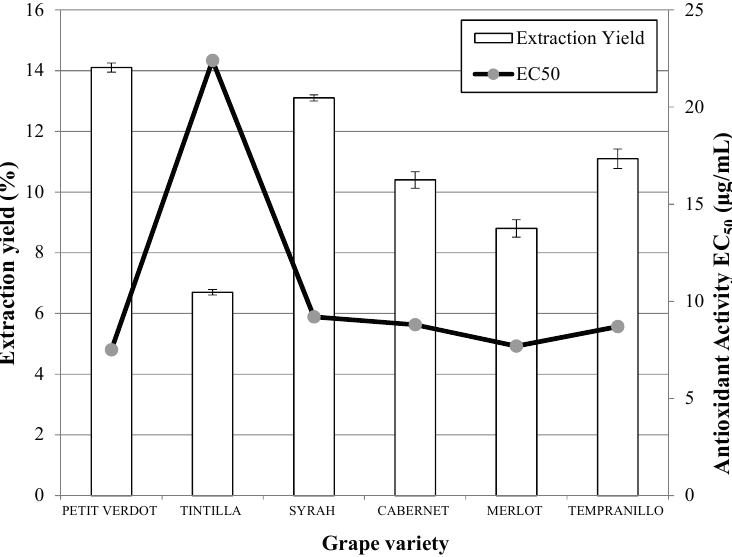
Figure 2. Extraction yield and antioxidant activity obtained by pressurized liquid extraction (PLE) whit ethanol as extraction solvent (120 bar, 100 °C, 10 g/min ethanol, 3 h) from different grape pomace